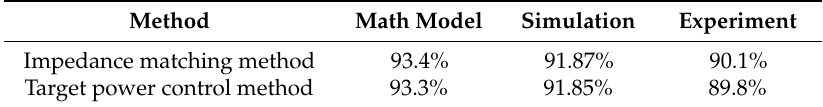
Table 2. Efficiency levels of different models for target power levels of 80 and 100